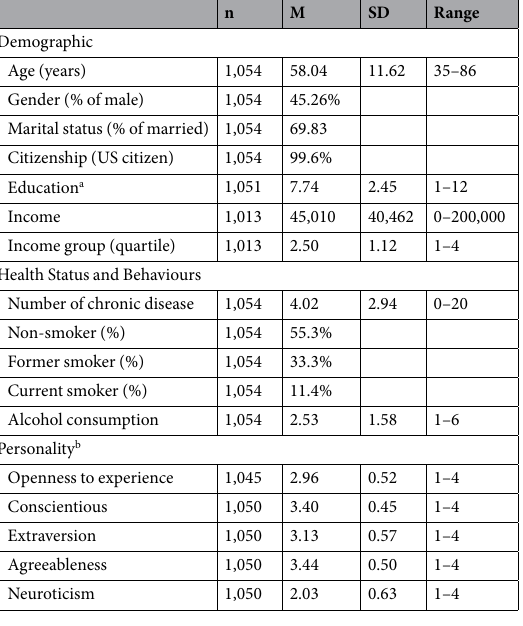
Table 3. Descriptive Statistics for Demographics, Health Status, Health Behaviours, and Personality Characteristics. Note. SDs are shown in parentheses. a Education attainment was rated on a scale of 1 (No school) to 12 (Ph.D, ED. D, MD, LLB, LLD, JD, or other professional degree). b Each personality score was calculated by averaging the respective personality items that were rated on a four-point Likert scale ( 1 = not at all , 4 = a lot ; Rossi 64 ), with higher scores reflecting a higher amount of that particular personality dimension (e.g., greater openness to